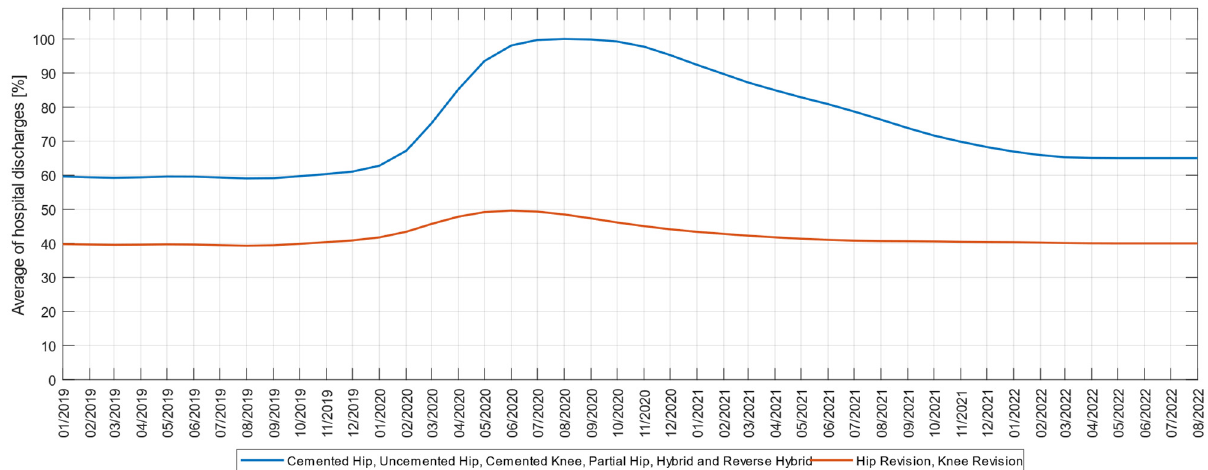
Figure 5. Three-month moving average of the average monthly percentage of cases discharged at home for cemented hip-uncemented hip-cemented knee-partial hip-hybrid and reverse hybrid, respectively revision knee-revision hip, in the interval 1 January 2019–31 March 2022.